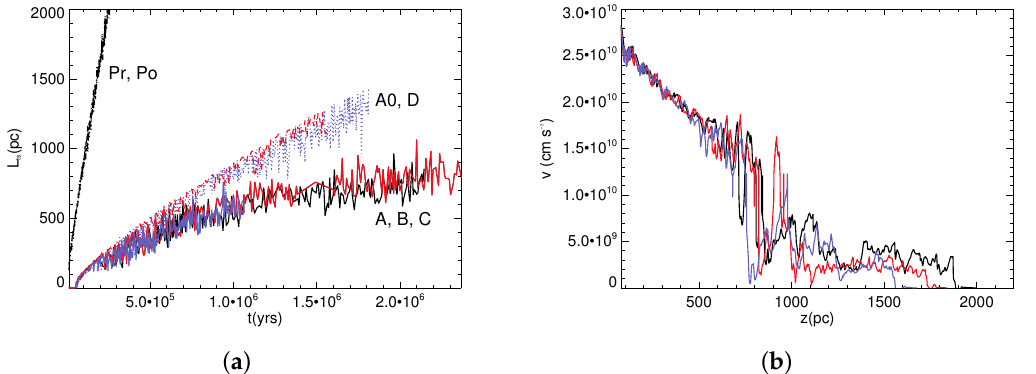
Figure 9. ( a ) Jet head position versus time for different mass-loaded jets. Pr, Po models correspond to jets with power 10 44 erg/s, model A0 is a low power jet ( ∼ 10 42 erg/s) with no mass-load, used as a fiducial simulation, models A, B, C and D have the same power as A0 but are mass-loaded by stars with ˙ M (cid:39) 10 − 12 M (cid:12) /yr (models A, B and C) or ˙ M (cid:39) 10 − 13 M (cid:12) /yr (model D). Models A, B and C only differ in the value of rest-mass density and temperature at injection, with increasing temperature and decreasing density from A to C (ranging from 3 × 10 11 to 3 × 10 13 K and 3 × 10 − 33 to 3 × 10 − 35 g/cm 3 ). The expansion velocity is clearly conditioned by entrainment, with one order of magnitude changes in mass-load implying critical changes in jet evolution. ( b ) Mean jet velocity along the first two kiloparsecs of evolution for models A, B and C (mass-loaded and decelerated). The disruption distance predicted by Equation (22) for these models is 200 pc. The difference between the prediction and the simulation is caused by the drop in stellar density with distance